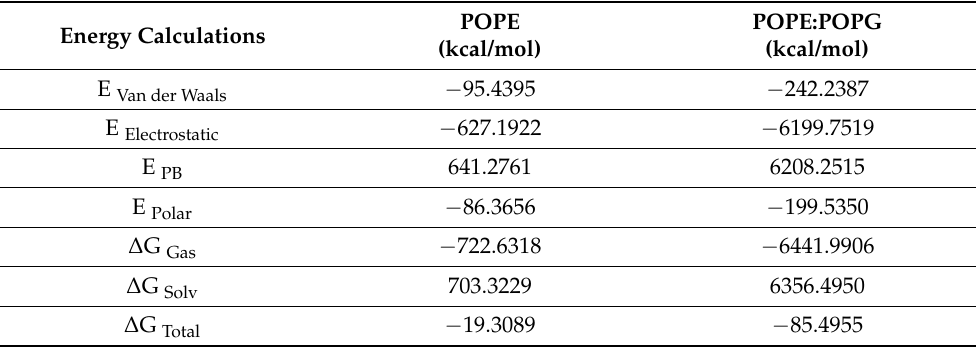
Table 1. The average binding free energy of LL-37 towards POPC and POPE:POPG calculated by MM/PBSA method in